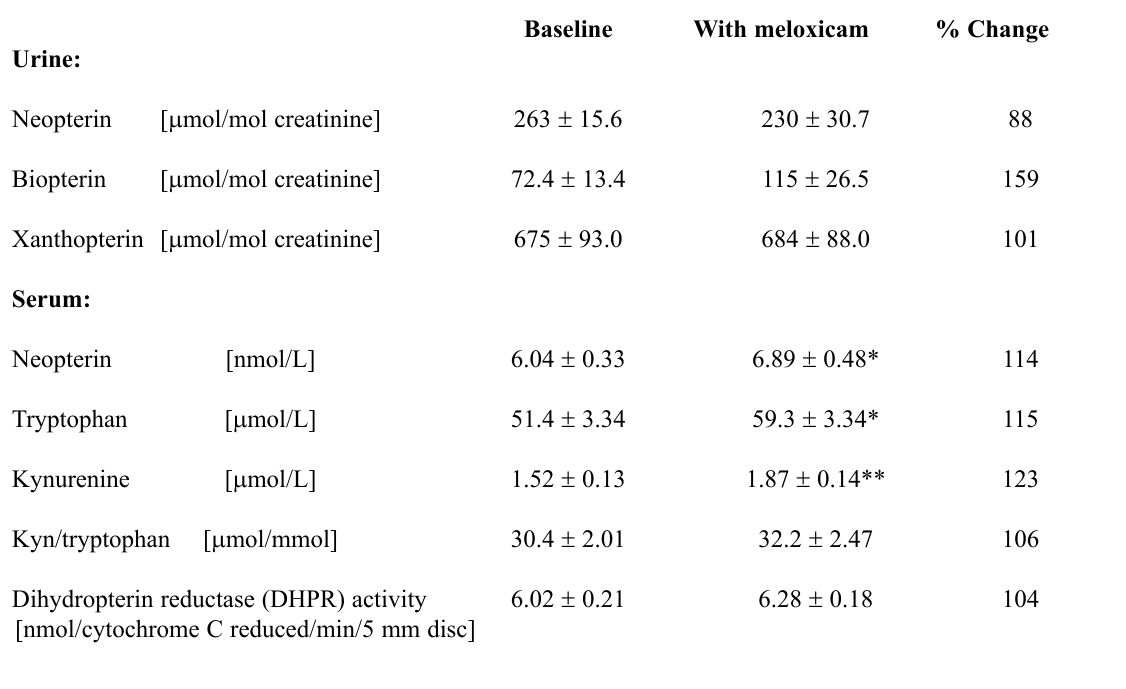
Table 1: Urinary and serum concentrations (mean values S.E.M.) of pterins and tryptophan metabolites in patients with degenerative disorders before and after 15 days of meloxicam treatment ( p 0.05; p